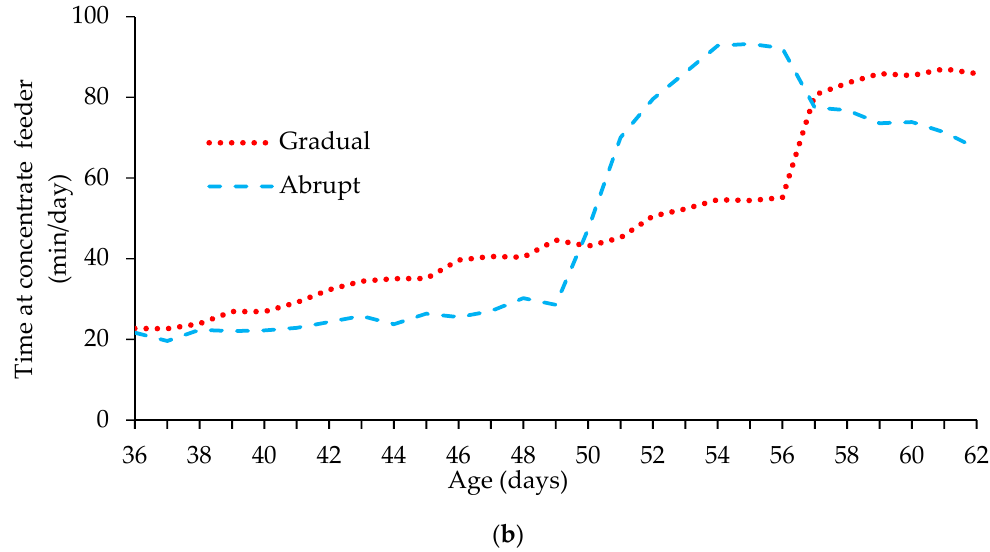
Figure 1. Time spent occupying the milk ( a ) and concentrate ( b ) feeders (min/day) between 36 and 62 days of age in calves weaned either gradually between 36 and 57 days of age or abruptly at 50 days of age.